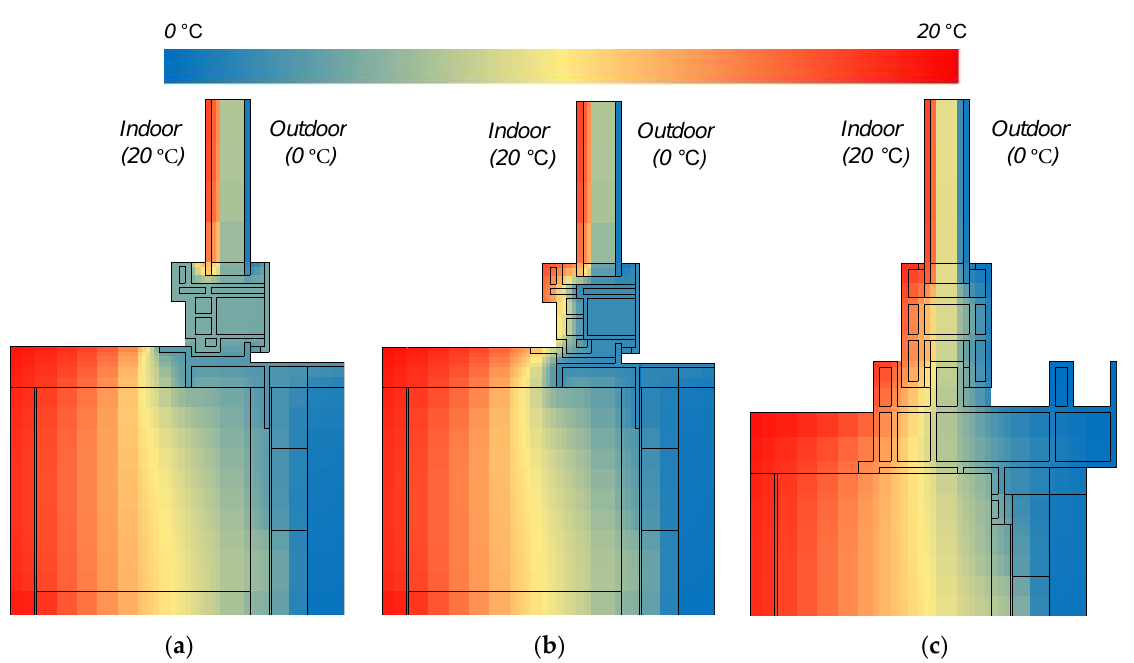
Figure 2. Temperature distribution for each reference frame. PVC, polyvinyl chloride. ( a ) Aluminum; ( b ) Composite; ( c ) PVC.